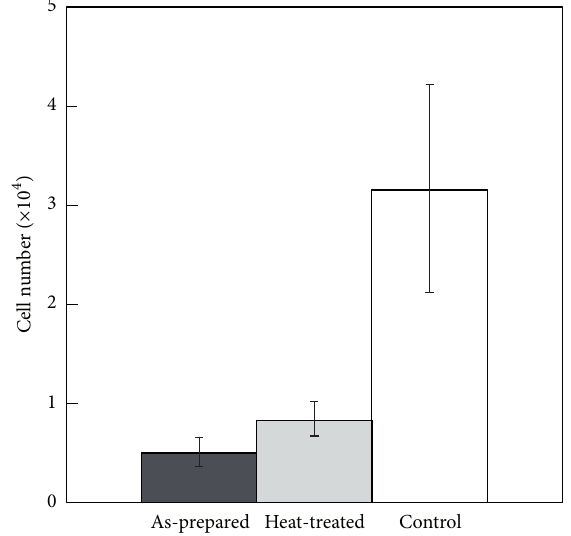
Figure 8: Live cell numbers on TNTZ samples after 5-day culture. Control: Thermanox. Heat treatment condition: 1000 ∘ C,